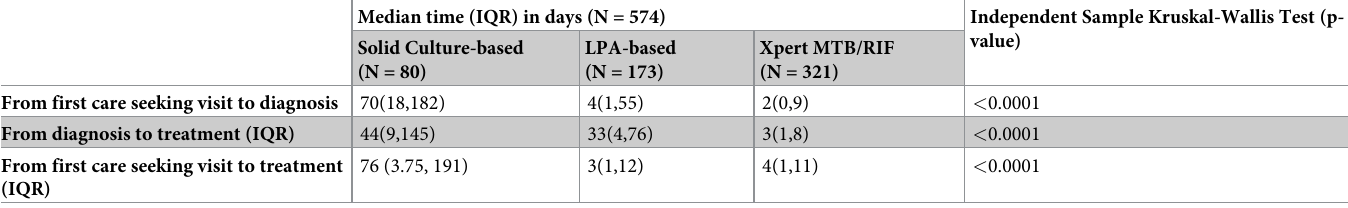
Table 2. Median time from first care-seeking visit to diagnosis and treatment, and diagnosis to treatment among DR-TB patients in the Amhara region, Ethiopia. Median time (IQR) in days (N =